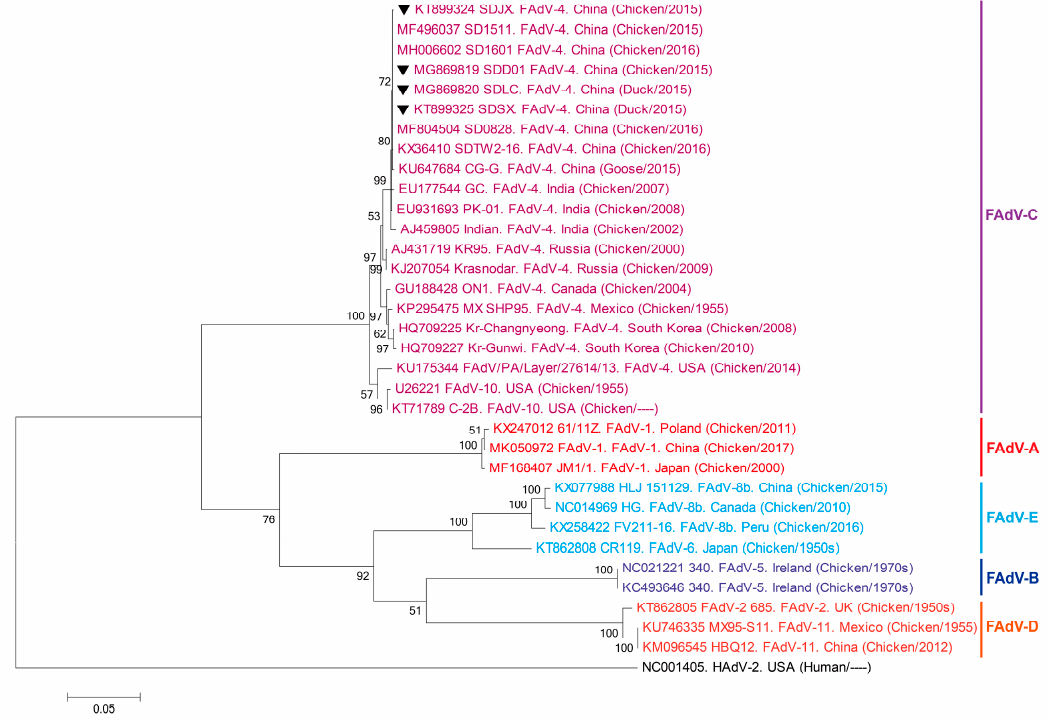
Figure 3. Phylogenetic tree of the hexon gene nucleotide sequences. Gene sequences of the SDJX, SDLC, SDSX, and SDD01 strains isolated from test samples and 30 other representative adenovirus strains constructed by the maximum likelihood method in MEGA 5.0. Bootstrap majority consensus values based on 1000 replicates are indicated at each branch point as a percentage. The location, source, and approximate dates of isolation are provided for each tree member. Black triangles indicate the four isolated Shandong strains. The GenBank numbers of reference strains are presented ahead of the reference strains. The scale bar indicates the number of nucleotide substitutions per site.